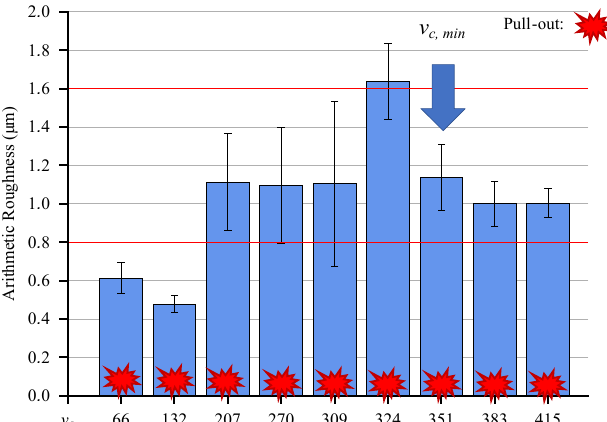
Figure 20. Determination of the minimal cutting speed of the universal tool, the evolution of the arithmetic roughness (µm) for different v c (m/min) with f z = 0.030 mm/tooth, a p = 3 mm, and a e = 0.5 mm.